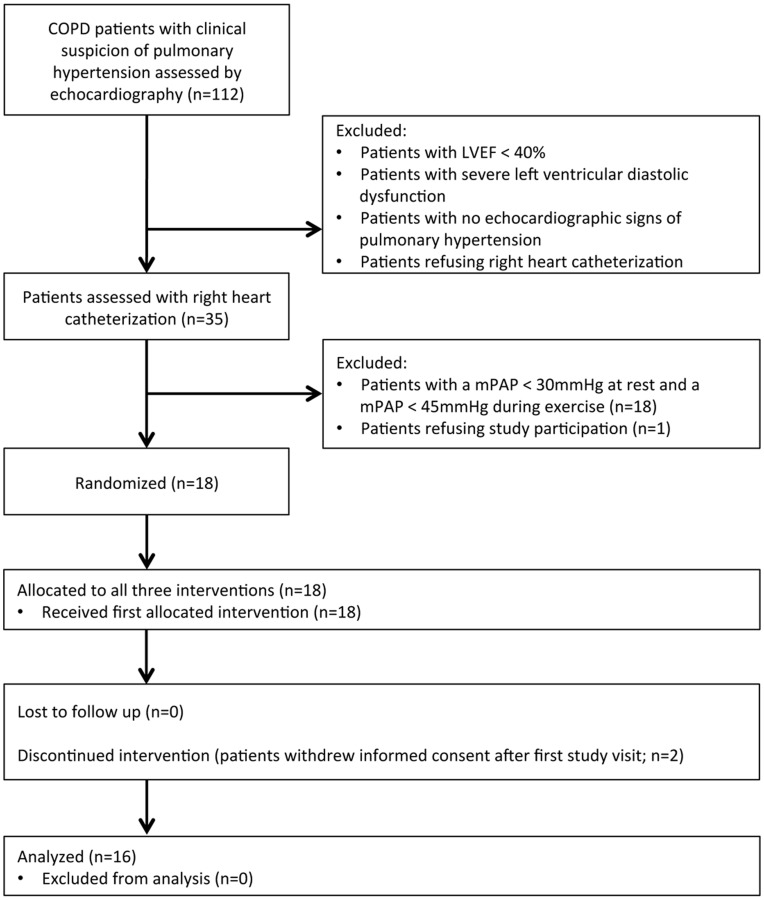
Screening, enrollment and interventions of the study participants.COPD denotes chronic obstructive pulmonary disease, CVP central venous pressure, LVEF left ventricular ejection fraction, mPAP mean pulmonary artery pressure, PH pulmonary hypertension, sPAP systolic pulmonary artery pressure, 6MWT six-minute walking distance.